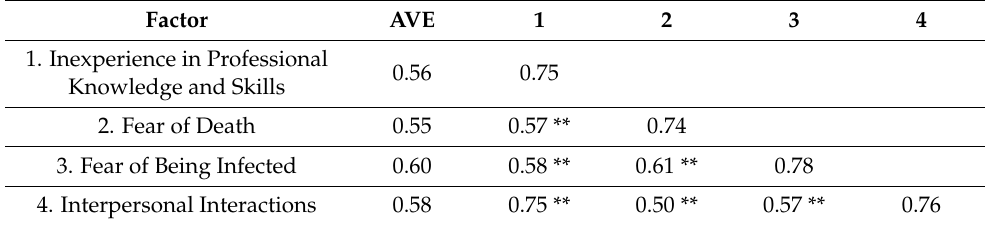
√ AVE), and correlations between factors.